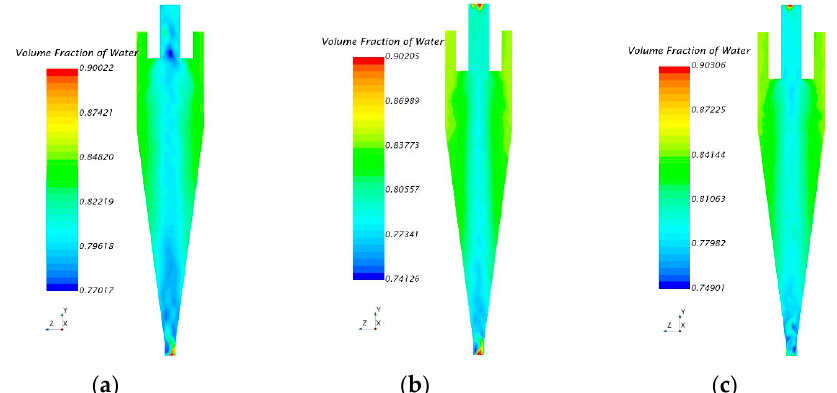
Figure 5. Volume fraction of water at 60 s at an inlet feed velocity of 5 m/s ( a ) VF = 20 mm ( b ) VF = 30 mm ( c ) VF = 35 mm.